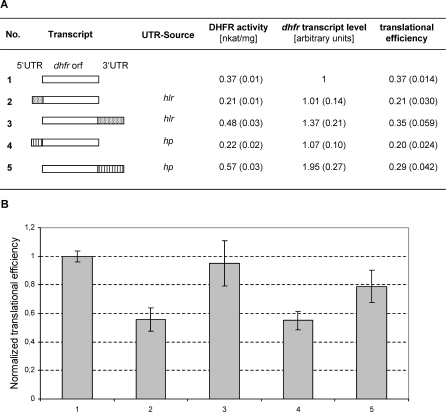
Characterization of the In Vivo Function of UTRs in H. volcanii Using a Reporter Gene(A) The dhfr reporter gene and the gene fusions containing 5′-UTRs and 3′-UTRs of genes number 2 and 3 of Table 2 are shown schematically. The genes encode a “HoxA-like transcriptional regulator” (hlr, number 2 in Table 2) and a “conserved hypothetical protein” (hp, number 3 in Table 2). The DHFR enzymatic activity, the dhfr transcript level, and the translational efficiency are tabulated. Three biological replicates were perfomed and average values were calculated. The numbers in parentheses are standard deviations. The translational efficiencies were calculated by dividing the DHFR activity by the dhfr transcript level.(B) The translational efficiency after normalization to the control transcript is visualized.